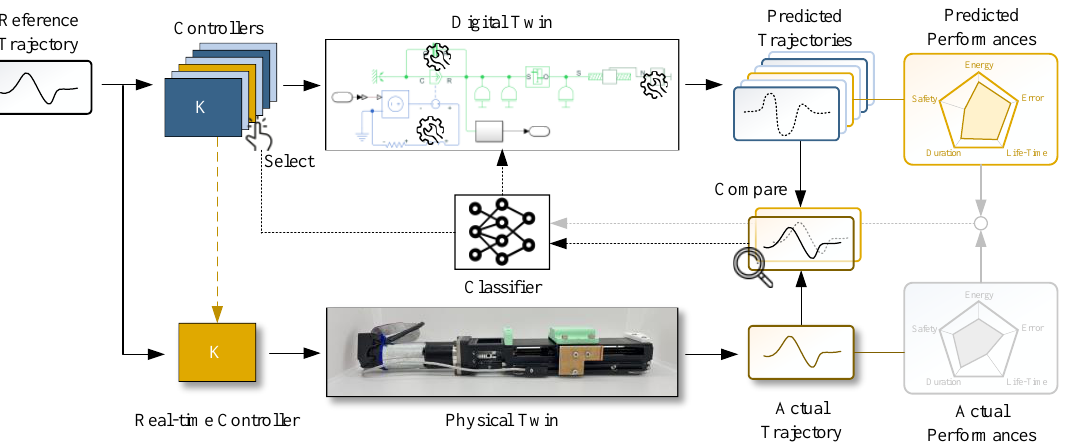
Figure 6. The proposed trajectory controller based on a digital twin